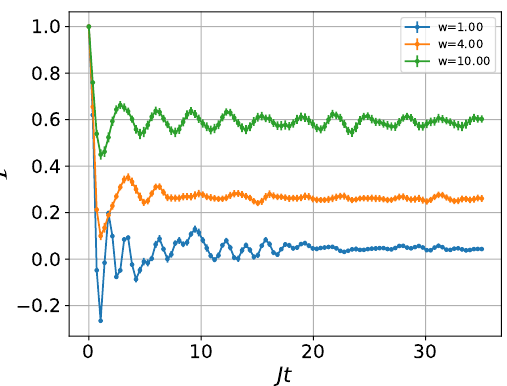
Figure 3: Sublattice imbalance I as a function of time, averaged over 100 disorder realizations for different disorder strengths. This data was taken on a chain of length L =